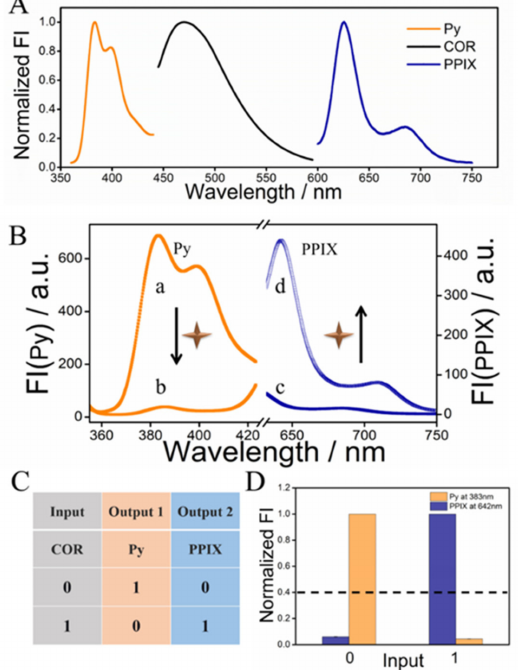
Figure 1. ( A ) The emission spectra of Py, COR and PPIX; ( B ) Fluorescence spectra of Py and PPIX in the absence and presence of COR, curve a/c: G1-A10-Py (200 nM) + Py-A10-G3 (200 nM), curve b/d: G1-A10-Py (200 nM) + Py-A10-G3 (200 nM) + COR (5 µ M); ( C ) Truth table of “YES-NOT” contrary logic pair; ( D ) Normalized Py and PPIX column bars of the YES-NOT pair under different input states; “0” represents the absence of COR and “1” represents the presence of COR. The error bars are obtained via three independent